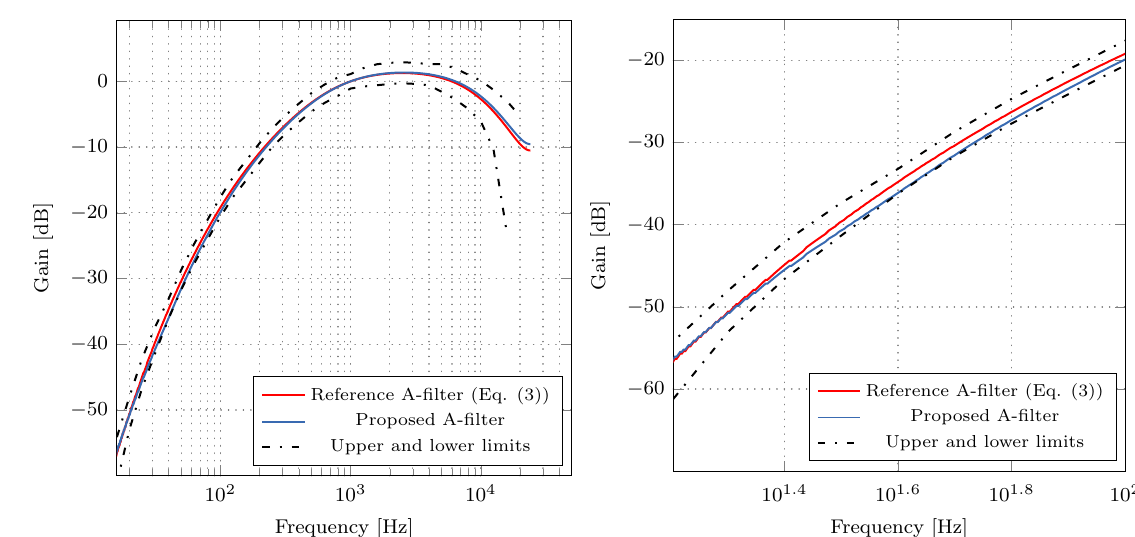
Figure 7. Magnitude responses of the proposed and reference digital A-weighting filters. Left : Magnitude response; Right : enlarged portion of the magnitude response.